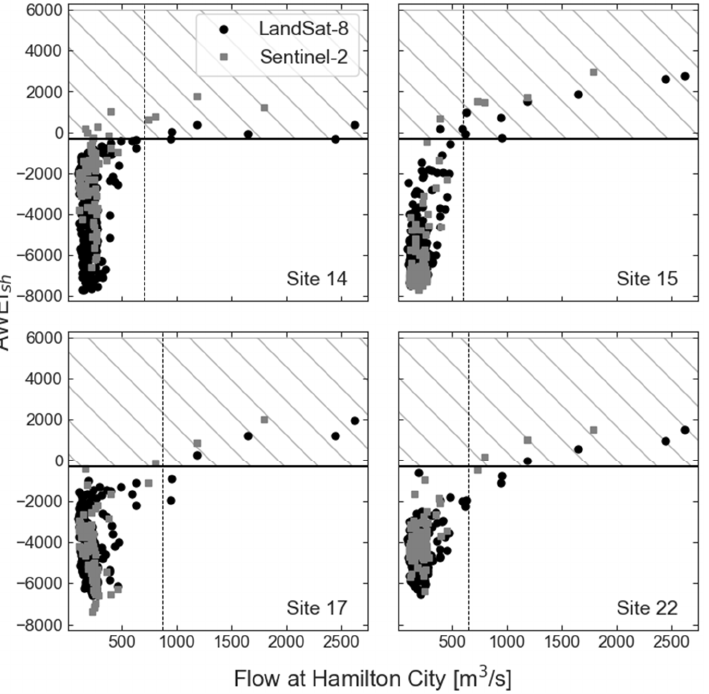
Figure 4. Computed AWEI values for surveyed off-channel habitats (Table 3) reported in [18] and existing daily Sacramento River flows recorded at Hamilton City (HMC). The hashed area indicates inundated conditions at the site. The vertical dashed line indicates required Sacramento River flows for off-channel activation [18].